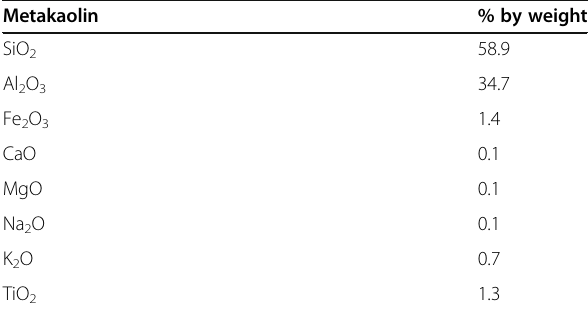
Table 2 Results of the chemical analysis via XRF Analysis of Metakaolin Argical TM M1000 as received from the producer